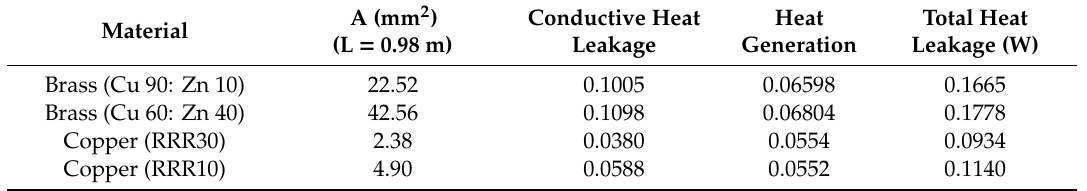
Table 2. Summary of experimental results and as compare with the design value.